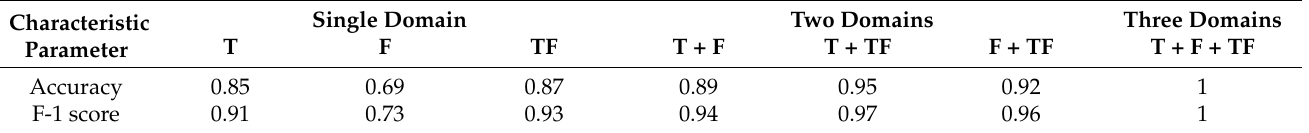
Table 5. Influence of different characteristic parameters on classification of PSO-SVM